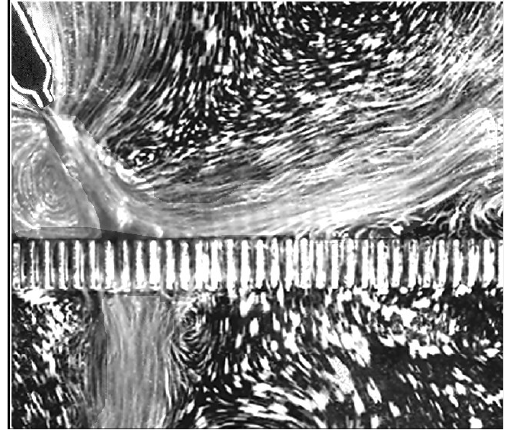
Fig. 4. Visualised oblique impingement of a planar jet on a wall consisting of a large number of thin simple parallel objects with open space between them. The objects are of rectangular cross section with equally rounded leading and trailing edges.